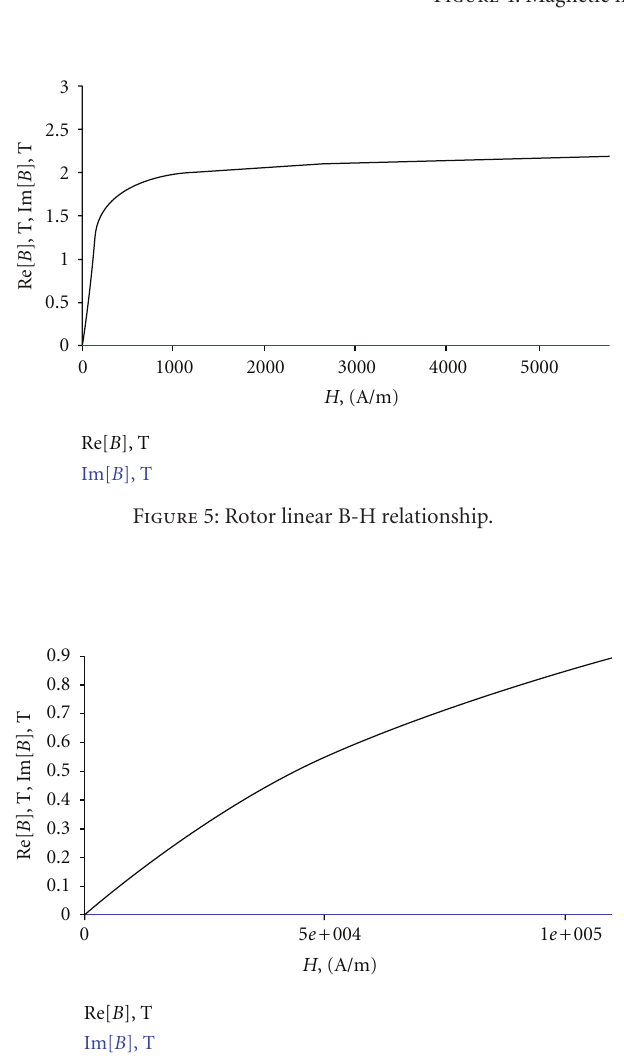
Figure 4: Magnetic flux density distribution.